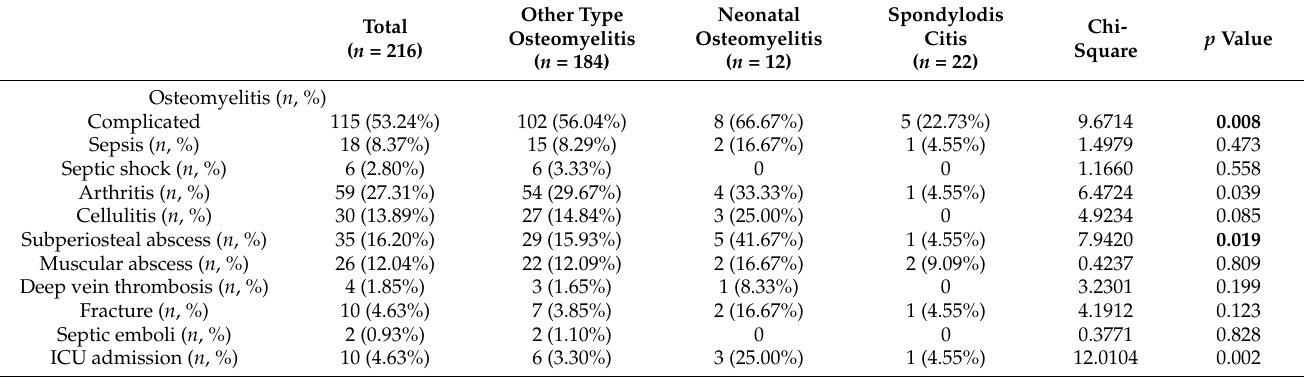
Table 2. Acute hematogenous osteomyelitis